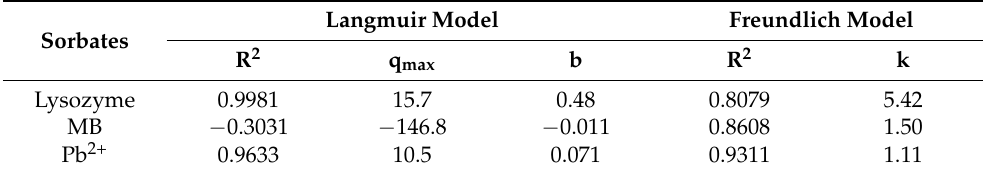
Table 1. Fitting the equilibrium data using the Langmuir and Freundlich models. Langmuir Model Freundlich Model Sorbates R 2 q max b